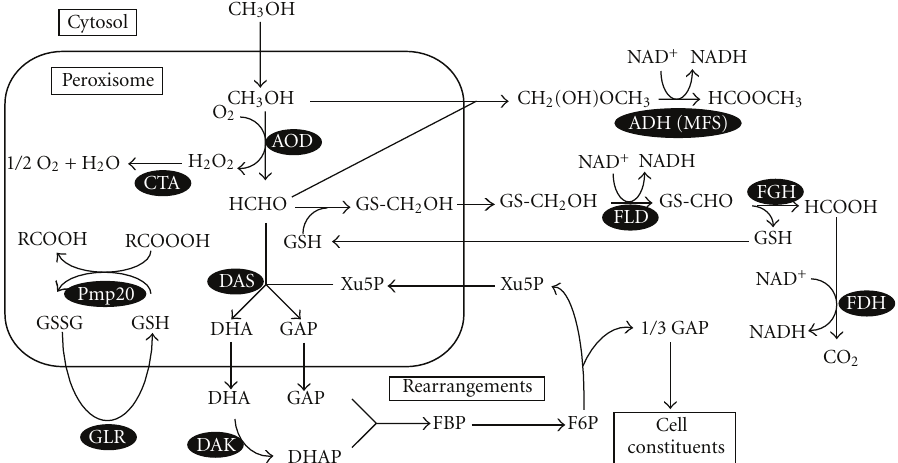
Figure 1: Outline of methanol metabolism in methylotrophic yeasts. Enzymes: ADH (MFS): alcohol dehydrogenase (methylformate- synthesizing enzyme); AOD: alcohol oxidase; CTA: catalase; DAK: dihydroxyacetone kinase; DAS: dihydroxyacetone synthase; FDH: formate dehydrogenase; FGH: S -formylglutathione hydrolase; FLD: formaldehyde dehydrogenase; GLR: glutathione reductase; Pmp20: peroxisome membrane protein which has glutathione peroxidase activity. Abbreviations : DHA: dihydroxyacetone; DHAP: dihydroxyacetone phosphate; F6P: fructose 6-phosphate; FBP: fructose 1,6-bisphosphate; GAP: glyceraldehyde 3-phosphate; GS-CH 2 OH: S -hydroxymethyl glutathione; GS-CHO: S -formylglutathione; GSH: reduced form of glutathione; GSSG: oxidized form of glutathione; RCOOOH: alkyl hydroperoxide; Xu5P: xylulose